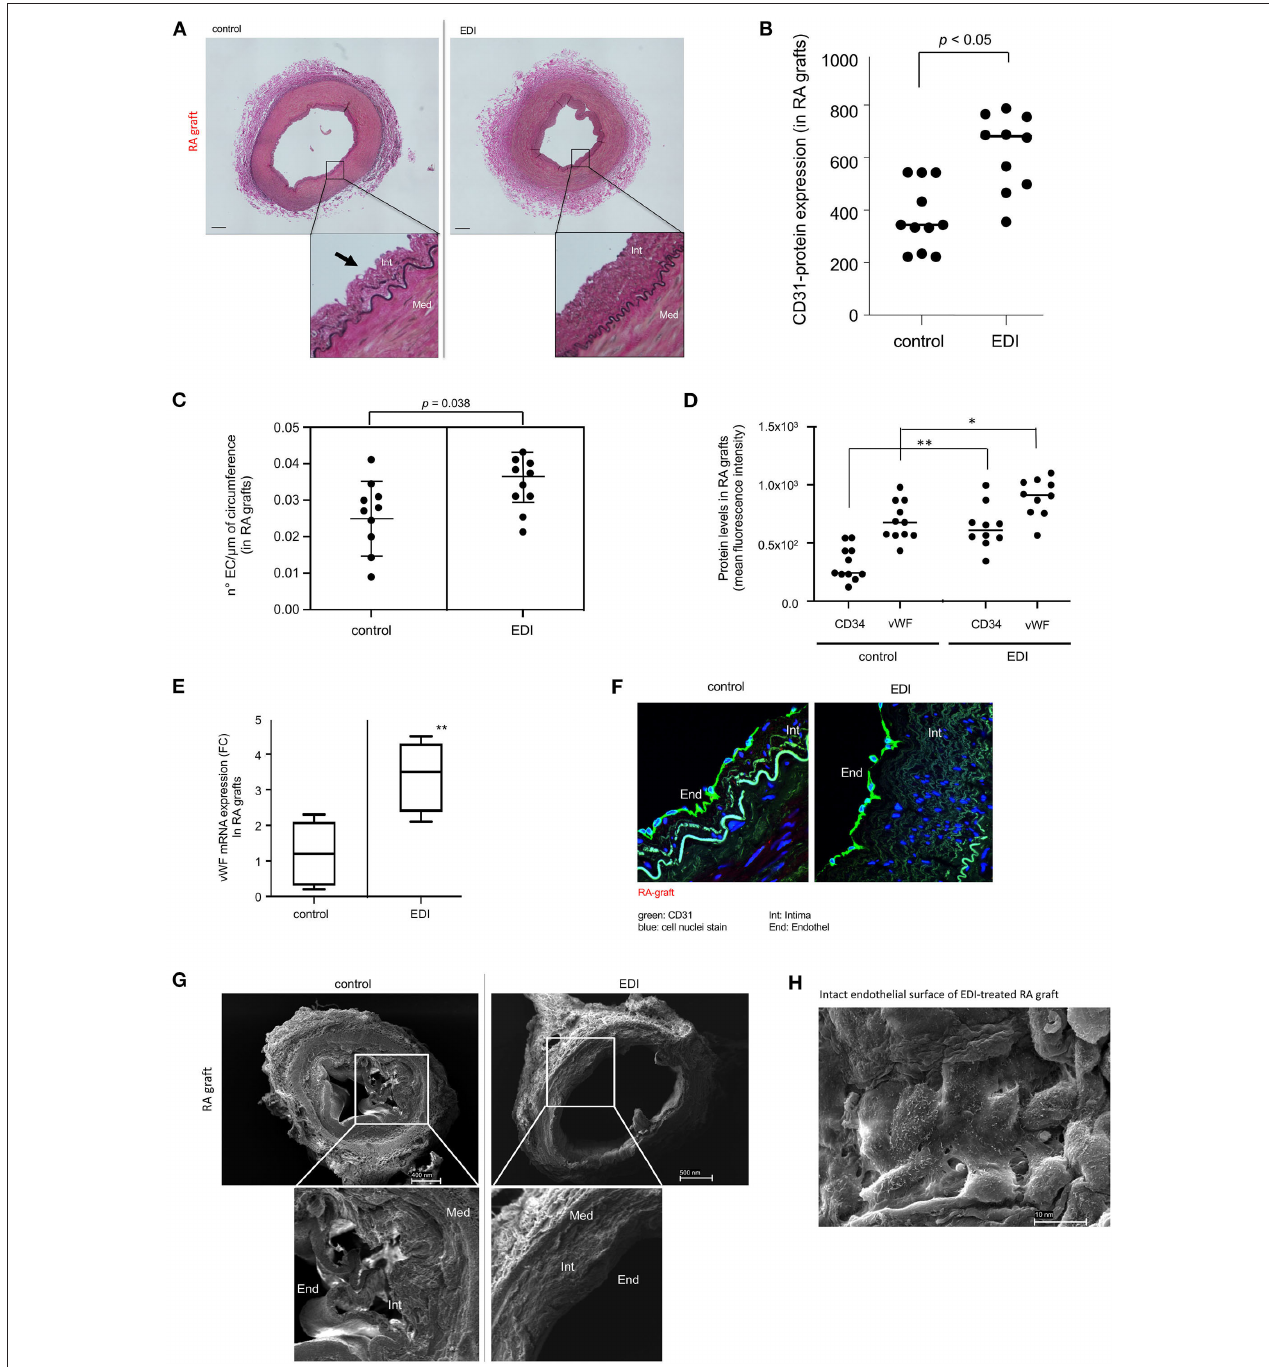
FIGURE 1 | Endothelial damage inhibitor (EDI) maintained homeostasis and integrity of endothelial cells (EC). (A) Photomicrographs of RA grafts treated with RL or EDI. RL treatment shows flattened intimal EC (black arrow). scale bar, 70 µ m. (B) Quantitative analysis of CD31 IF staining in RA sections. (C) Quantitative analysis of EC count lining in the circumference of RA. SD is given. (D) Significant decrease of CD34 and vWF in RL-treated RA grafts. * p < 0.05; ** p < 0.01. (E) vWF mRNA expression by qRT-PCR assay in EDI vs. RL ** p < 0.01. (F) Representative image of CD31 IF staining in EDI-treated RA grafts. scale bar: 20 µ m; green, CD31; blue, cell nuclei staining (DAPI). (G) Representative SEM image of EDI and RL treated RA grafts. EC, endothelial cells; Int, intima; Med, media. (H) Top view on cross section of EDI vs. RL-treated RA samples with intact endothelial layer. scale bar, 10nm.